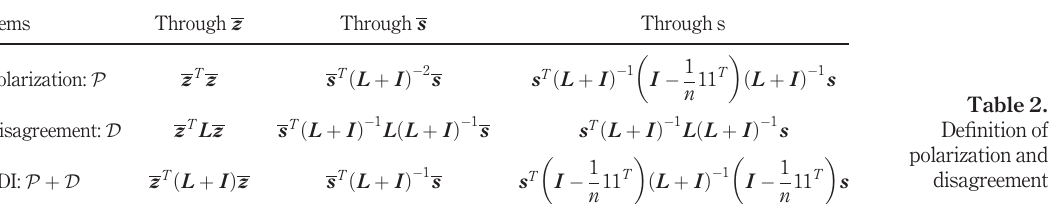
Table 2. De fi nition